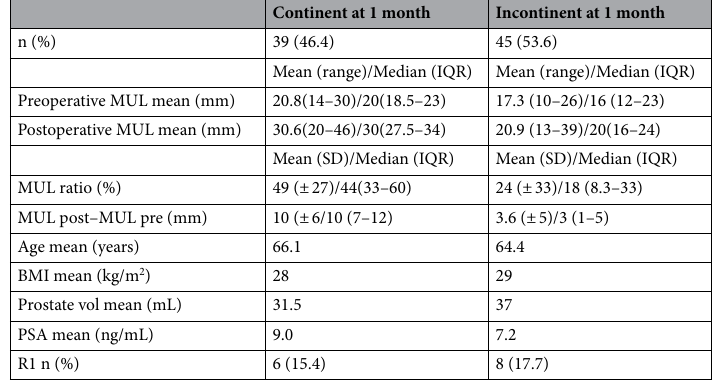
Table 3. Characteristics of patients continent and incontinent one month after laparoscopic radical